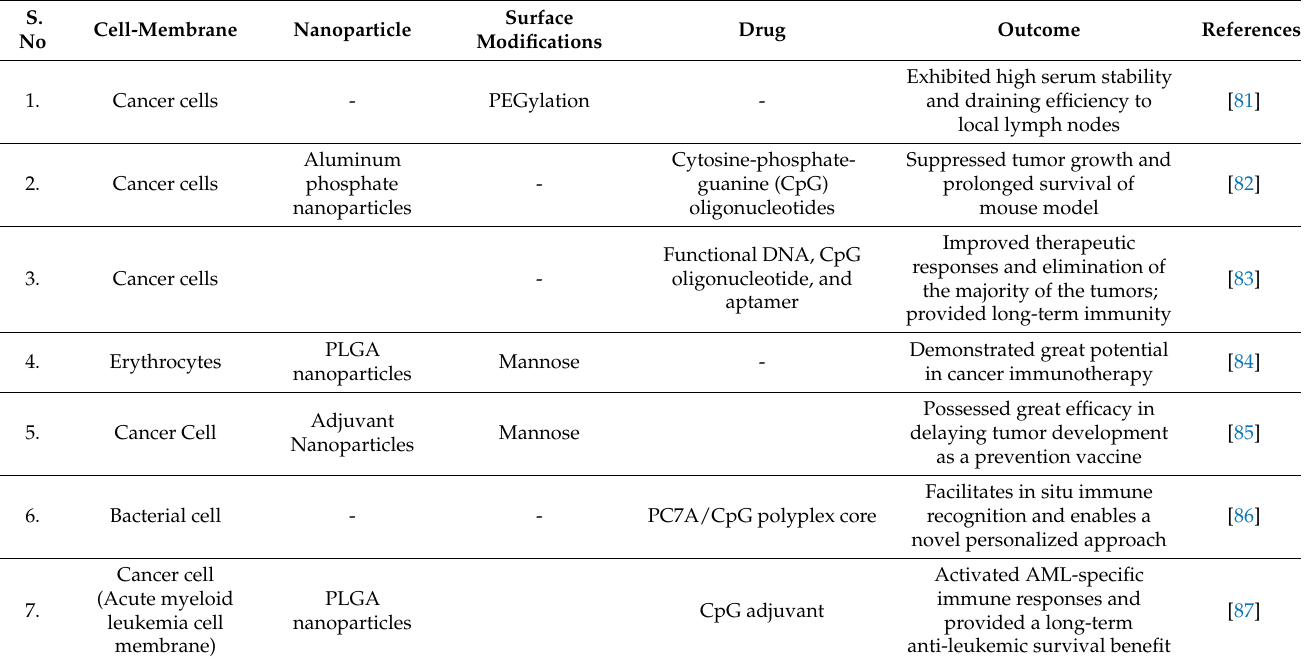
Table 4. Nanodecoys for vaccination in cancer